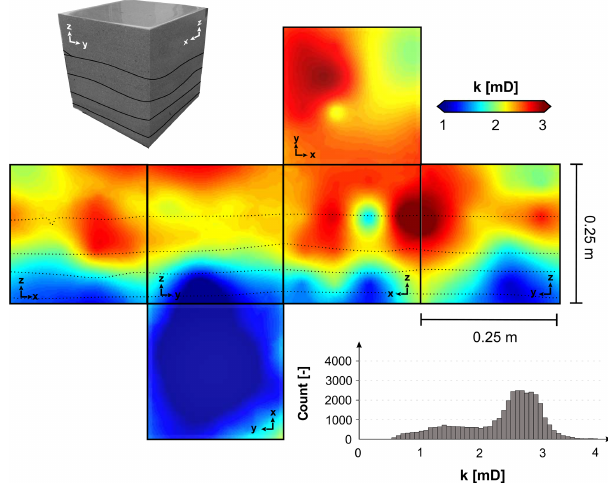
Figure 10. Spatial distribution of the intrinsic permeability mod- eled with a simple kriging interpolation. The histogram shows a bimodality of the distribution split up into the basal beds and upper- most